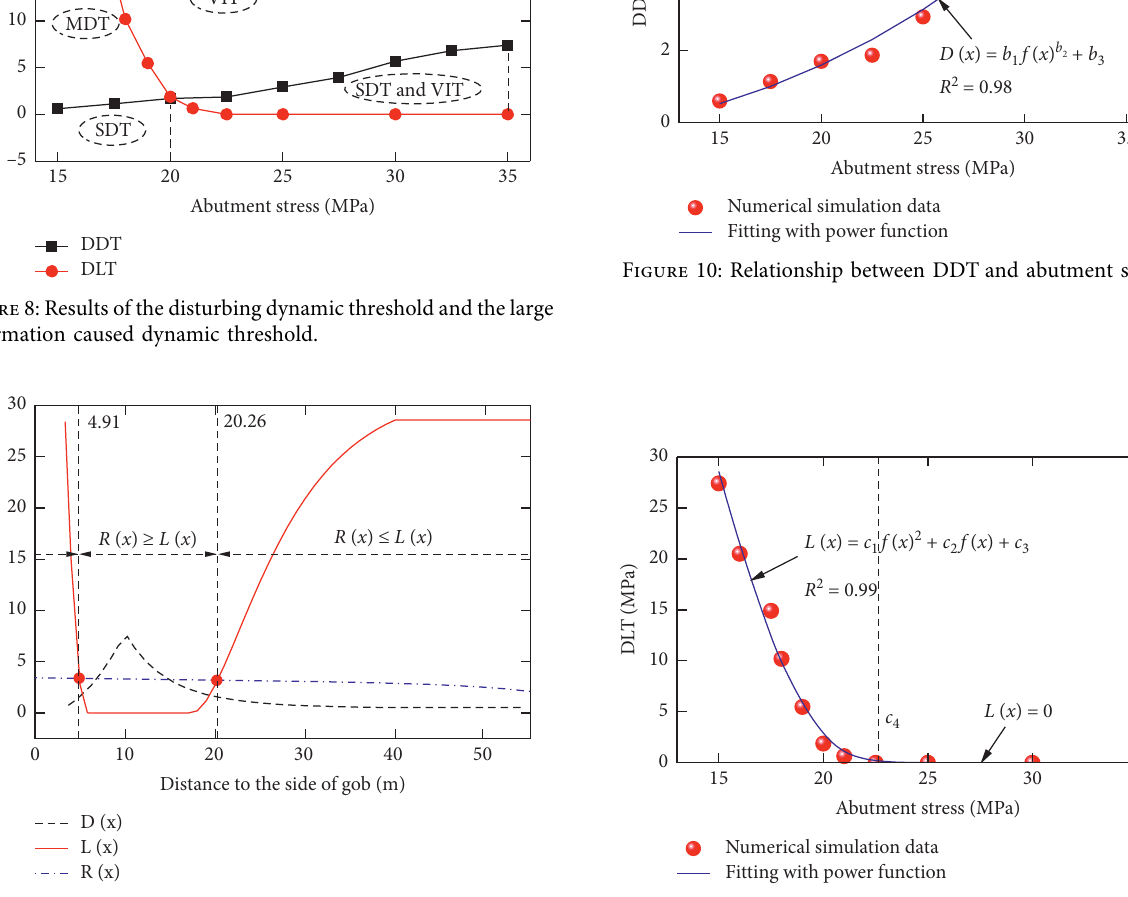
Figure 9: Distribution of evaluation index.